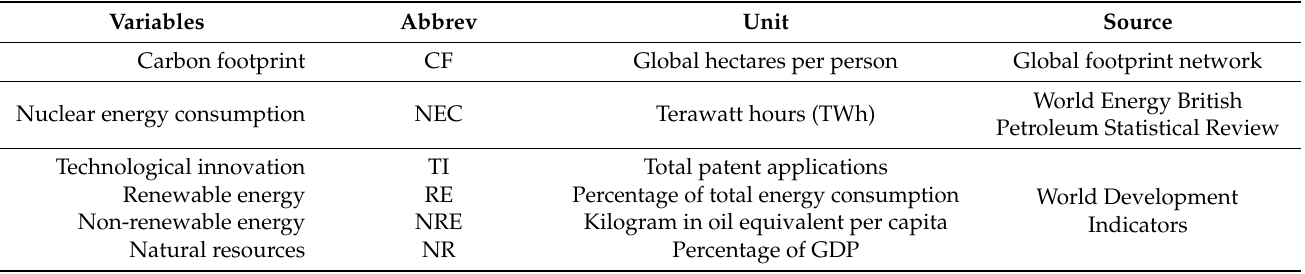
Table 1. Description of the